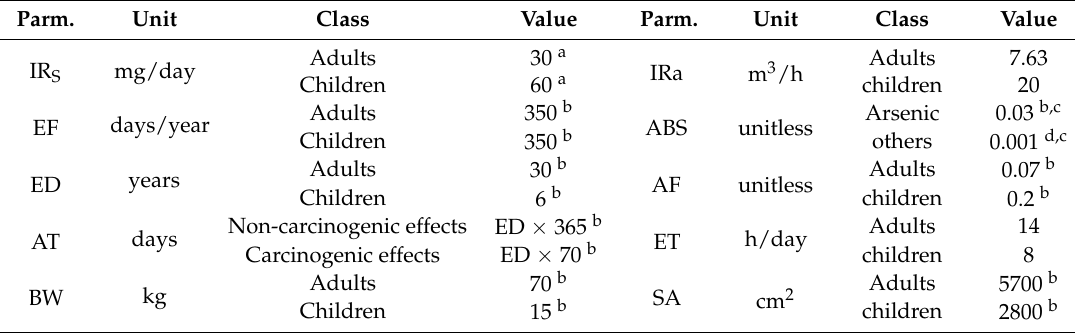
Table 2. The value of parameters for exposure